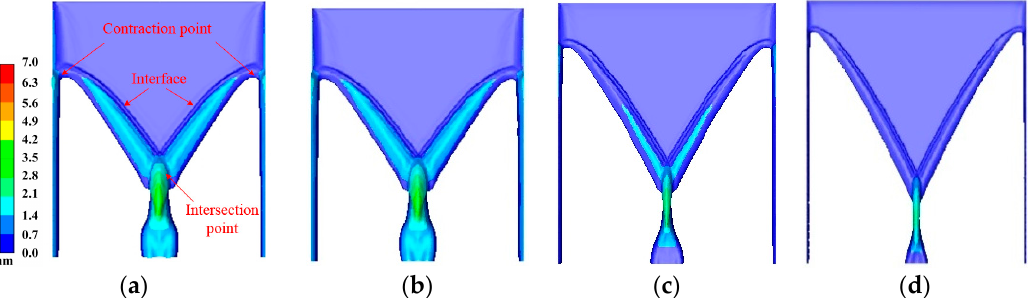
Figure 5. Film distribution and film thickness for different fluids: ( a ) water; ( b ) seawater; ( c ) R290; and ( d ) O 2 .